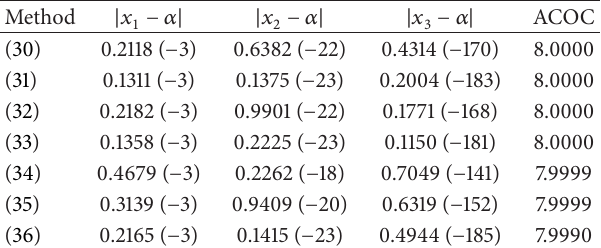
Table 2: Numerical results with 𝑓 2